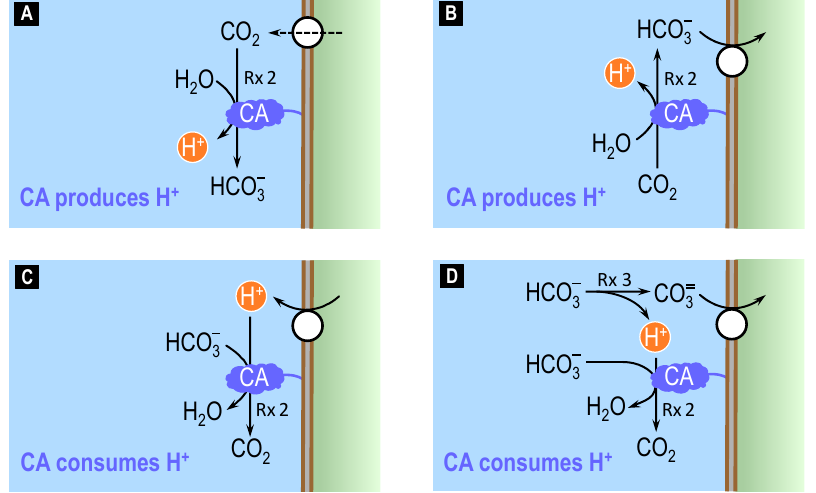
Figure 3. Interaction of fluxes of CO 2 , HCO 3 − , H + , and CO 32 − with CA-catalyzed reactions on the outer surface of a cell. ( A ) If CO 2 exits the cell, CA tends to minimize the rise in [CO 2 ] at the outer surface (oS) of the cell membrane, and maximize the fall in pH oS . ( B ) If HCO 3 − enters the cell, CA tends to minimize the fall in [HCO 3 − ] oS and maximize the fall in pH oS . ( C ) If H + exits the cell, CA tends to minimize the rise in [H + ] oS (i.e., minimize the fall in pH oS ). ( D ) If CO 32 − enters the cell, CA tends to minimize the fall in [CO 32 − ] oS (indirectly) and the fall in pH oS (directly). Rx = reaction; the number following the abbreviation ‘Rx’ indicates the numbering of the reaction in the main text. CA = carbonic